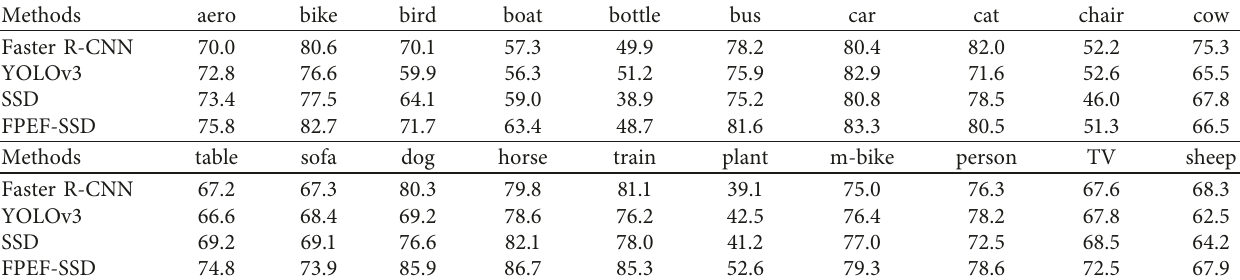
Table 3: Comparison of results of Pascal VOC